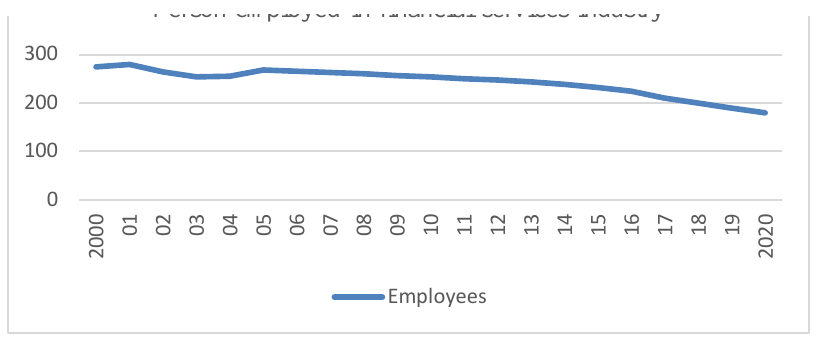
Fig.2: Number of people employed in financial services is declining; Source: CBS 2018